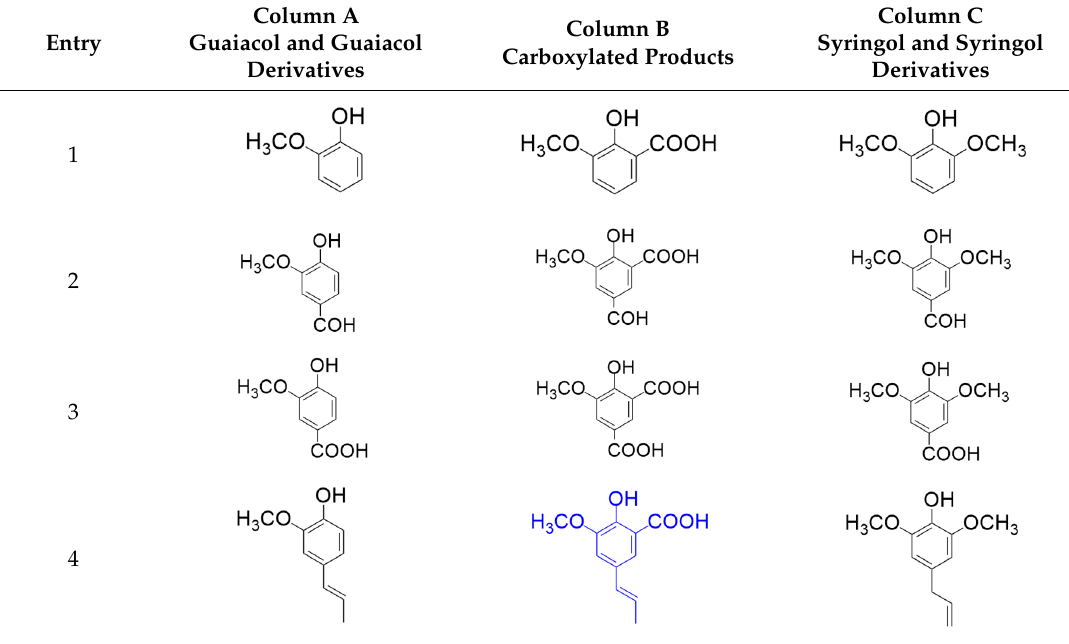
Table 11. Column A and C show the monomeric hydroxyaromatic compounds obtained from chemical and physico-chemical treatment of lignin analyzed in Table 2. Column B shows the ortho -carboxylated products of guaiacol-derivatives obtained by an enzymatic carboxylation reaction (the ortho -carboxylated product shown in entry 4 has not been reported in the literature, therefore, it is presented in blue color).